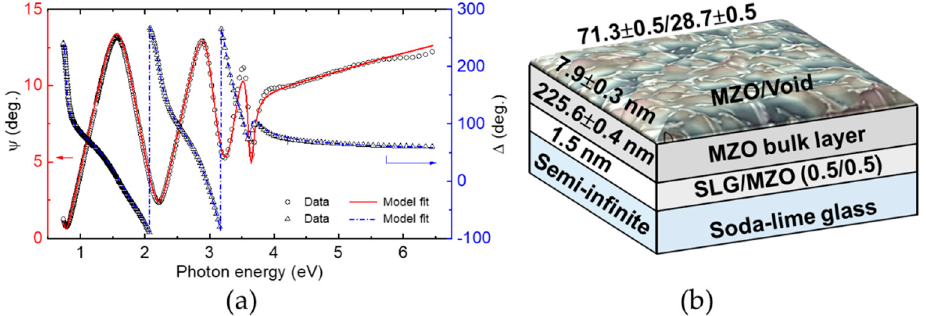
Figure 4. ( a ) Ellipsometric spectra ( ψ , ∆ ) for a Mg x Zn 1 − x O sample fabricated on a soda lime glass substrate with power levels of 240 W and 500 W applied to the ZnO and MgO targets, respectively, yielding a Mg content of x = 0.32 ± 0.06 and a bandgap of E 0 = E g = 3.690 ± 0.002 eV. The experimental data (points) are plotted along with the best fitting simulation (lines). The plot corresponds to results for a single representative location with coordinates (3.75, 4.69) (in cm), measured such that the center of the 15 cm × 15 cm sample is (0, 0). Here the Mg x Zn 1 − x O bulk layer and effective thicknesses are ~225.6 nm and 232.0 nm, respectively. The parameters defining the complex dielectric function spectra from the optical model appear in Figure 5 with best polynomial fits versus E 0 = E g reported in Table 2. ( b ) The structural model and associated parameters corresponding to the best fit in ( a ) are shown.